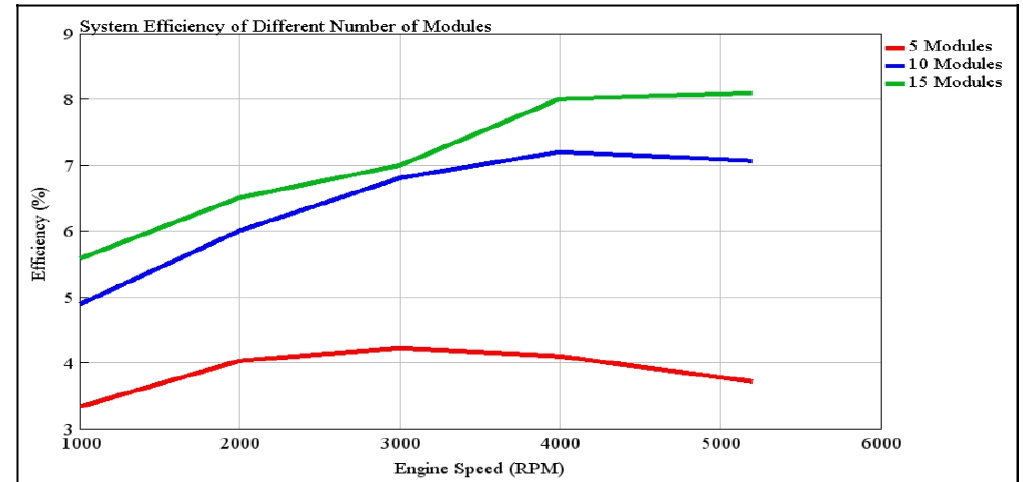
Figure 23. System efficiency of different number of modules. Figure 23. System e ffi ciency of di ff erent number of modules.